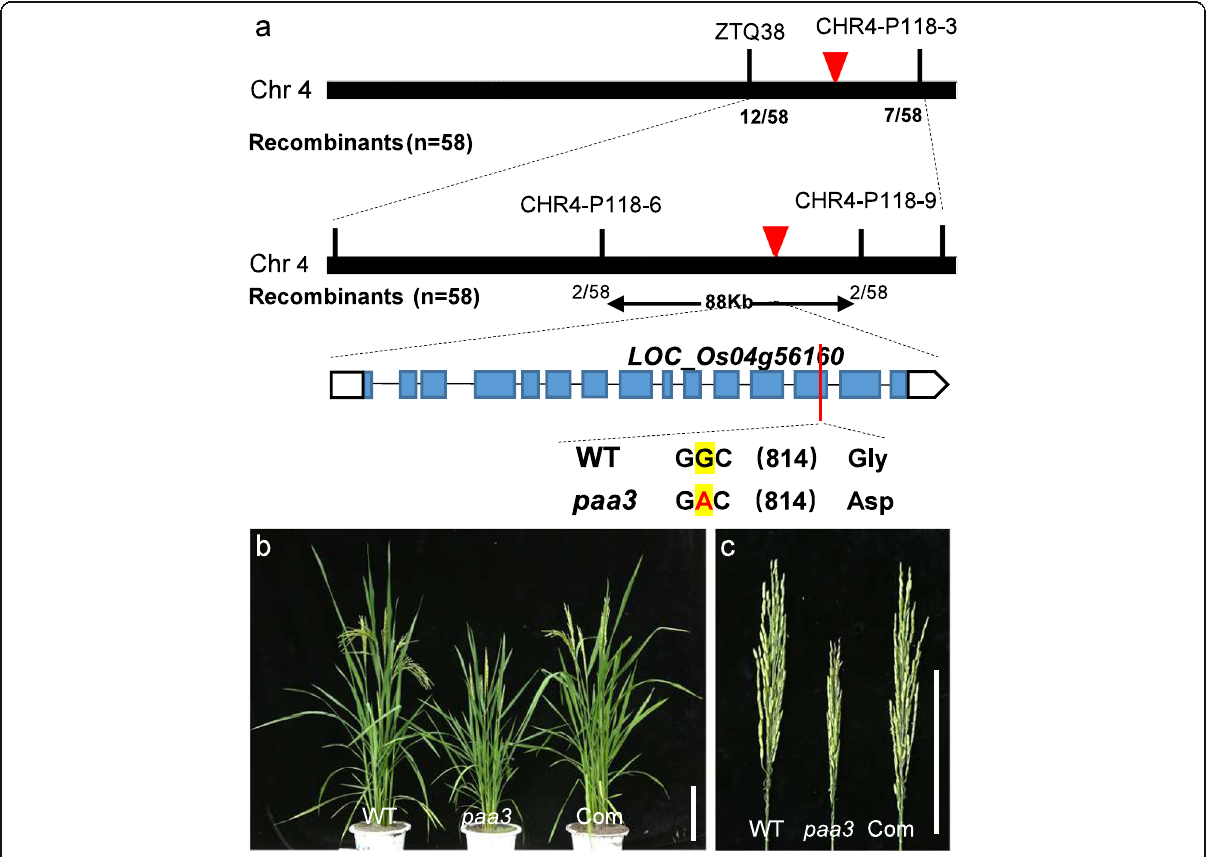
Fig. 3 Molecular identification of PAA3 and genetic complementation test. a : Fine mapping of the PAA3 gene. b , c : Genetic complementation of paa3 . b : Image of whole plants. c : Image of panicles. Bars ( b , c ) 15